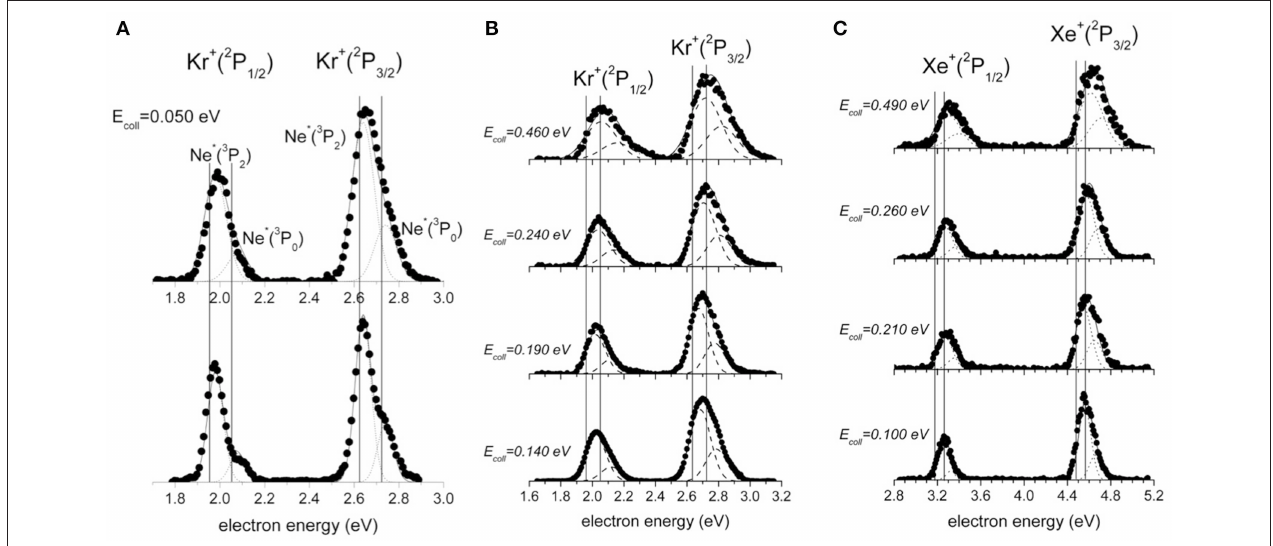
FIGURE 3 | The electron energy spectra for the ionization of Kr and Xe by metastable Ne * ( 3 P 2,0 ). (A) The spectrum for the ionization of Kr at 0.050eV collision energy under low (upper part) and high (lower part) resolution conditions. (B) Spectra for Ne * ( 3 P 2,0 )-Kr ionization measured as a function of the collision energy. (C) Spectra for Ne * ( 3 P 2,0 )-Xe ionization measured as a function of the collision energy. The vertical lines define the position of peaks in canonical photo-ionization